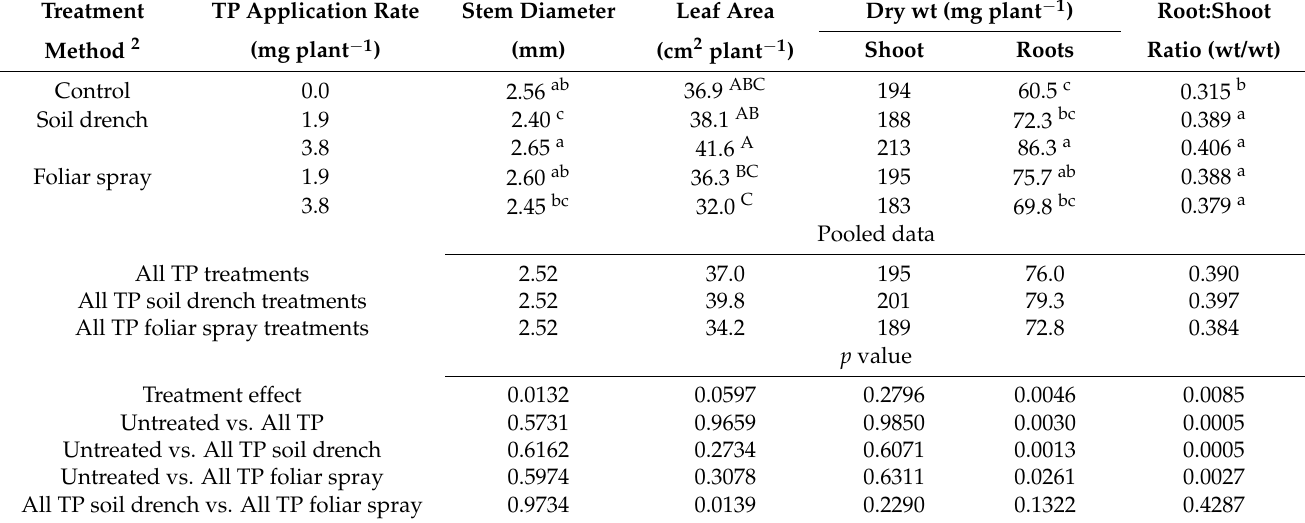
Table 6. Shoot and root growth of soybean seedlings as affected by tryptophan (TP) soil drench and foliar spray treatments 1